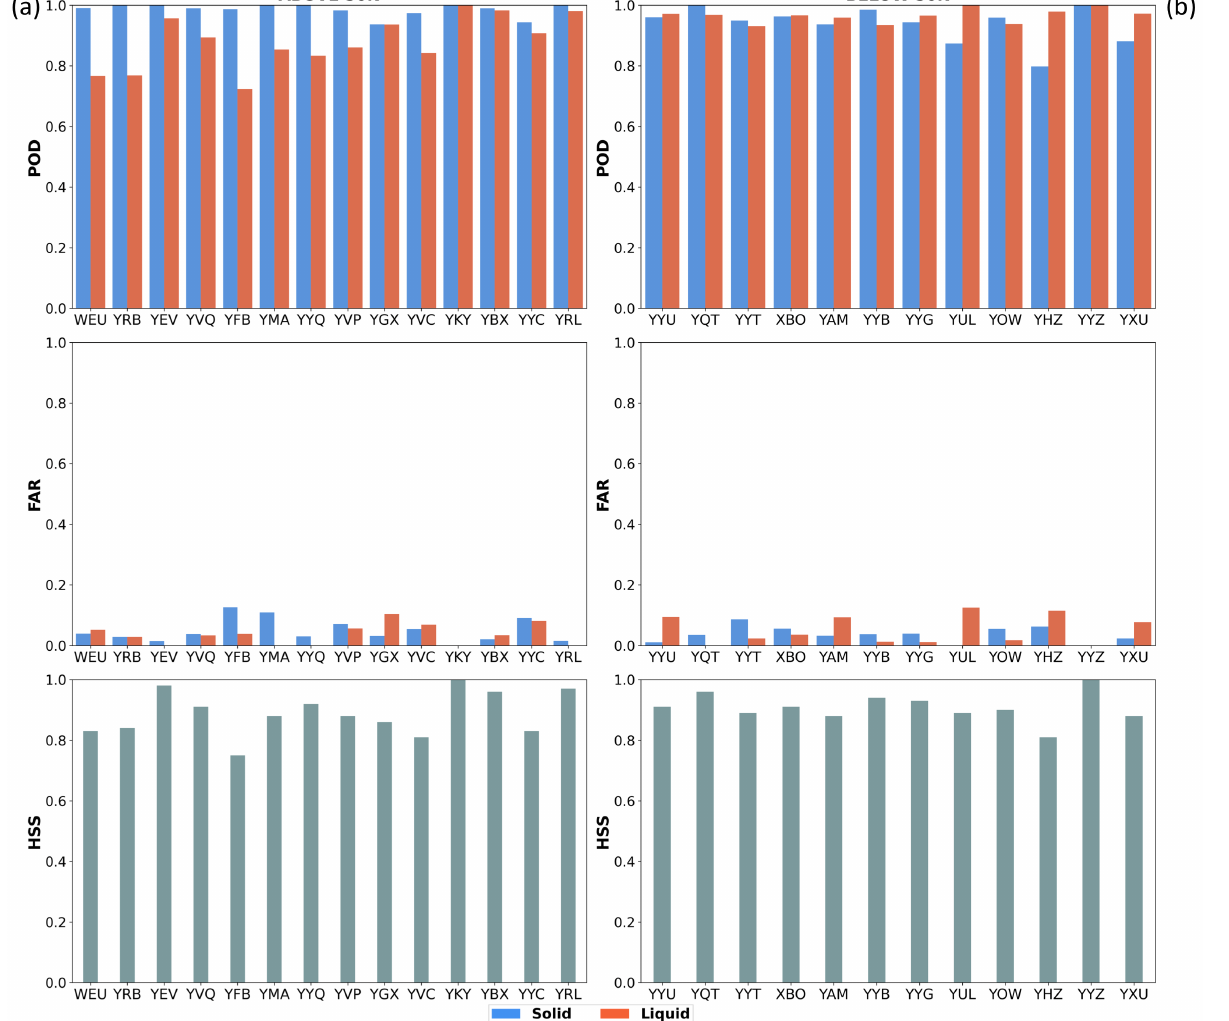
Figure 7. Same as the third column from the left in Figure 3, except here each metric is shown for all 26 ECCC weather stations (Table 3). The stations are grouped by latitude: ( a ) all stations > 50 ◦ N; and ( b ) all stations < 50 ◦